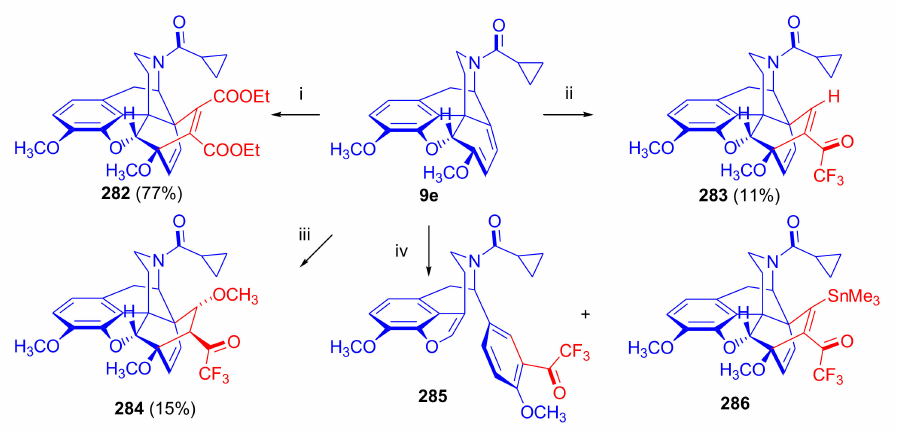
Figure 77. Reaction of N 17 -cyclopropylcarbonyl-northebaine with acetylenic dienophiles. Reagents and conditions : (i): diethyl acetylenedicarboxylate, acetonitrile, 50–55 ◦ C, 77%; (ii): trifluoroacety- lacetylene, THF, < 40 ◦ C, 11%; and (iii) (1) trifluoroacetylacetylene, THF < 40 ◦ C, (2) CH 3 OH, reflux,